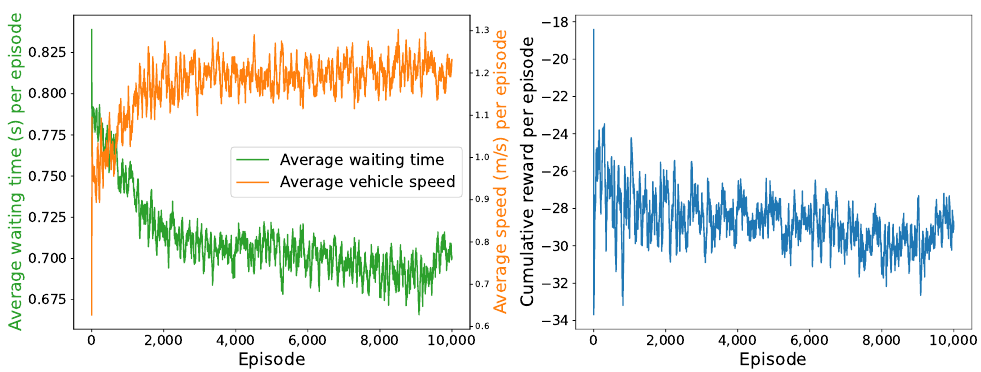
Figure 8. Convergence of the proposed DRL network.